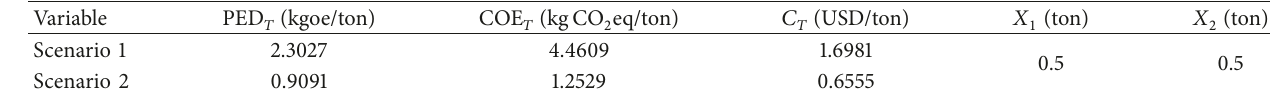
Table 5: The results for the variables of this study.